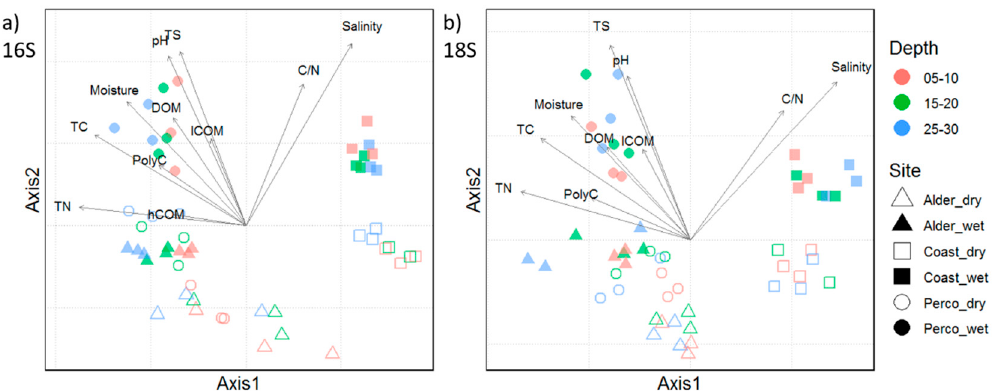
Figure 2. NMDS plots showing ( a ) prokaryotic and ( b ) eukaryotic community compositions. Symbols show triplicates of cores and indicate the study sites; the color indicates the depth in cm (see legend). Environmental vectors with a significance of p < 0.05 are shown in black. TN: total nitrogen, hCOM: humic like carbon, TC: total carbon, PolyC: carbon polymers, DOM: dissolved organic matter, lCOM: low-molecular-weight organic matter, TS: total sulfur, C / N: carbon / nitrogen ratio. Triangles: alder, squares: coast, circles: Perco. Open symbols: dry, filled symbols: wet.